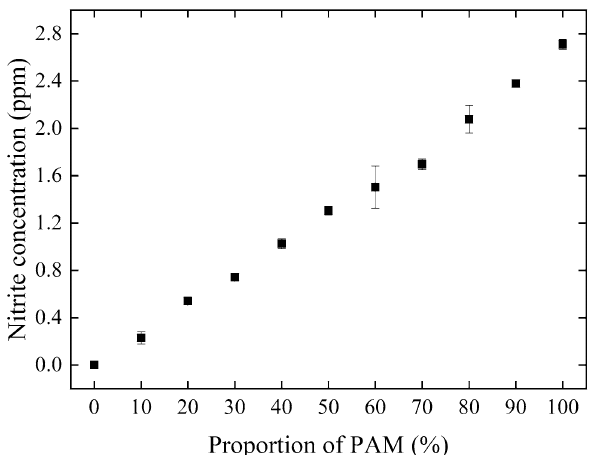
Figure 5. PAM prepared with a plasma exposure time of 120 s was serial diluted with untreated RPMI medium. The nitrite concentrations were measured for PAM present at different proportions. Data are mean and SD values (n =